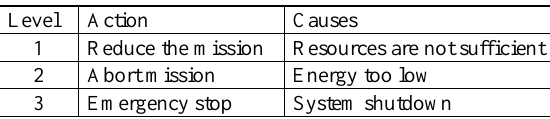
Table 1: available actions at